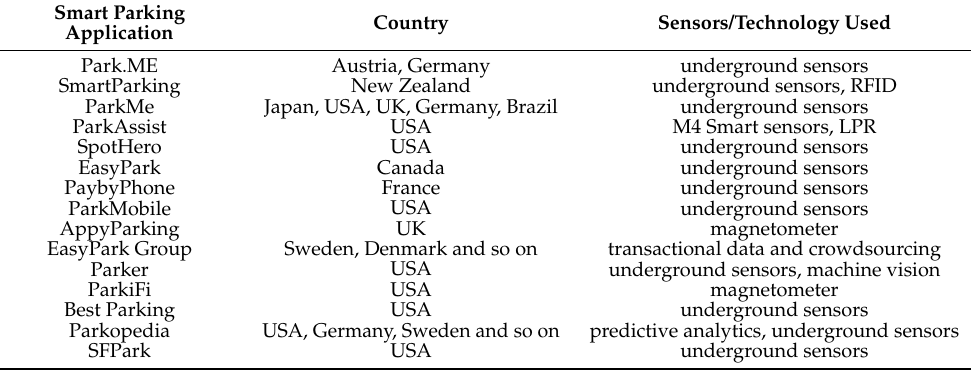
Table 1. International smart parking solutions